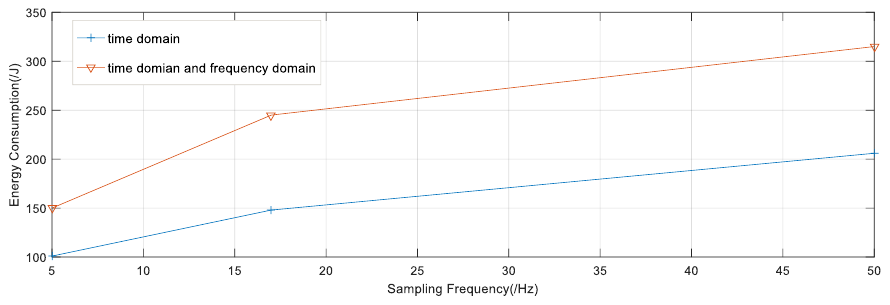
Figure 3. Energy consumption for smartphone between 2 h.